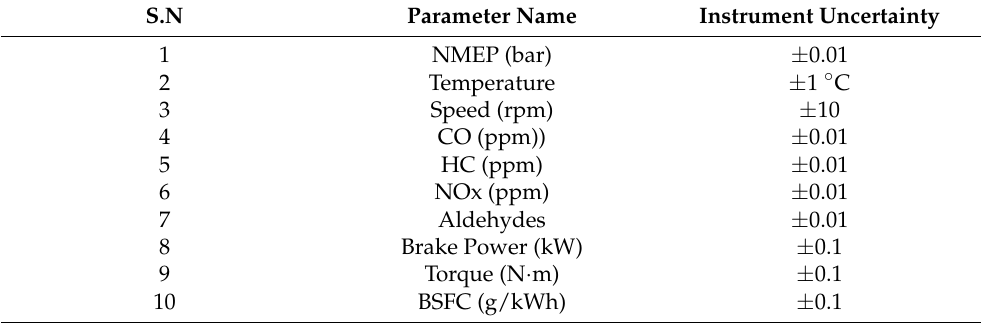
Table 3. Uncertainty